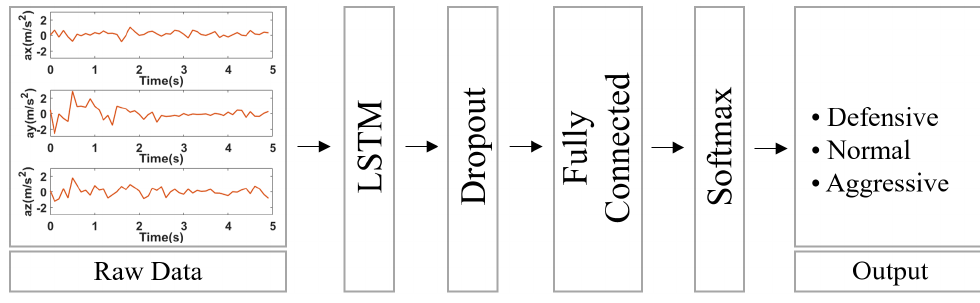
Figure 5. LSTM structure